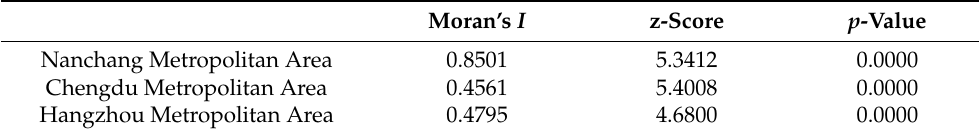
Table 5. Global Moran’s I of LUCE sinks.